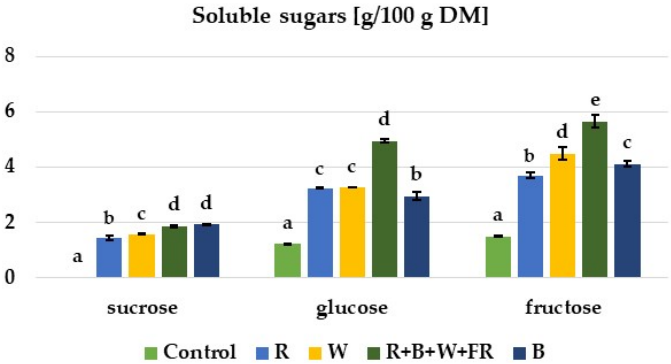
Figure 6. The soluble sugar levels in the leaf petioles of Rheum rhaponticum ‘Raspberry’ after 10 weeks of growth in GM1 and under different LED light treatments (control—natural light, R—red, W—white, B—blue, R+B+G+FR—far red). Bars represent means ± SE. Values marked with the same letter within each sugar type do not differ significantly according to the Duncan’s test ( p = 0.05).